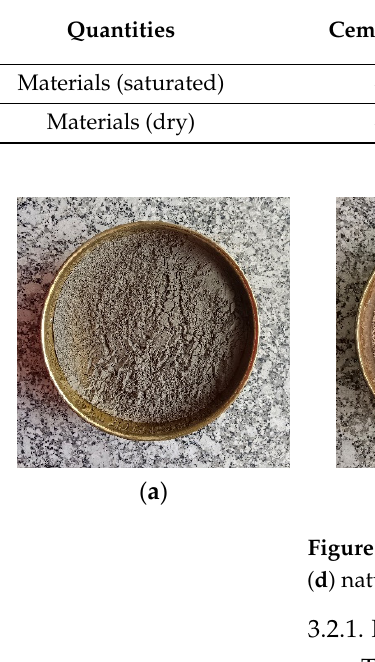
Table 3. Dimensions and number of specimens.